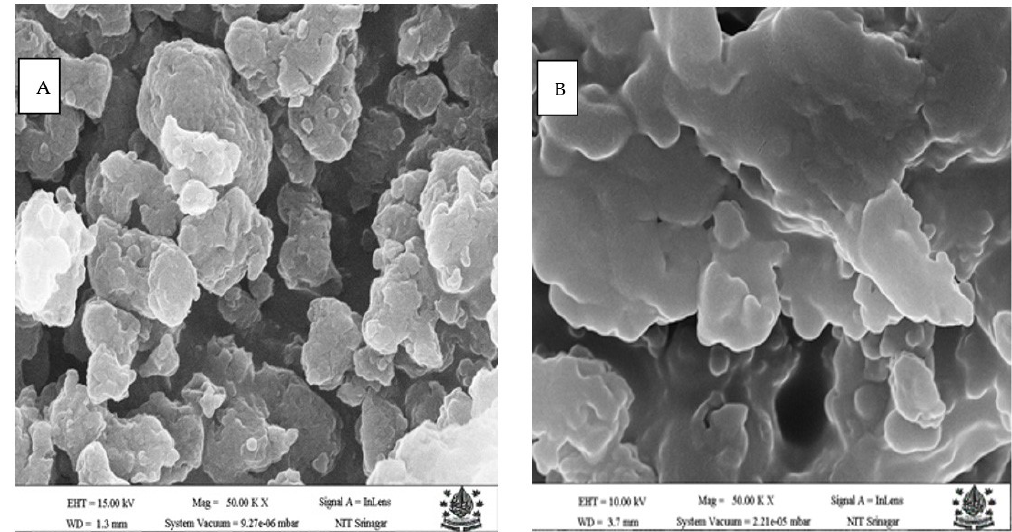
Figure 2. The SEM images of B-Glu (C) ( A ) and O-Glu (C) ( B ). Here, B-Glu (C) represents catechin encapsulated in barley β -glucan, O-Glu (C) catechin encapsulated in oats β -glucan